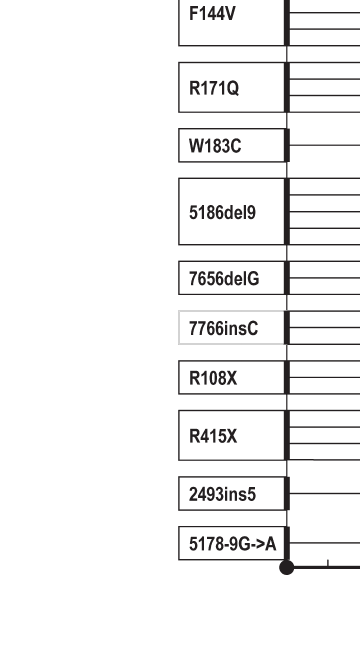
Figure 1 Timetable of clinical